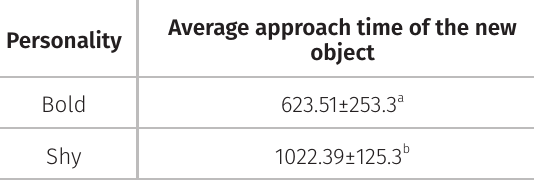
Table I. Mean time (s) spent by Nile tilapia ( Oreochromis niloticus ) of different personalities to approach of the new